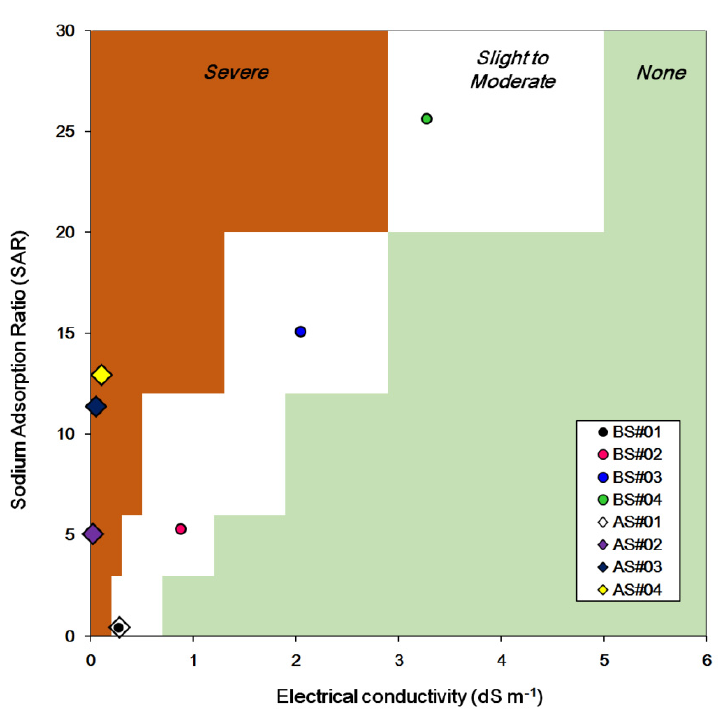
Figure 2. Soil sodicity potential risk, evaluated using the sodium adsorption ratio (SAR) and the electric conductivity (EC w ) of irrigation water. BS: before water treatment using the BWD system, i.e., saline water irrigation; AS: after water treatment using the BWD system, i.e., desalinated water irrigation.